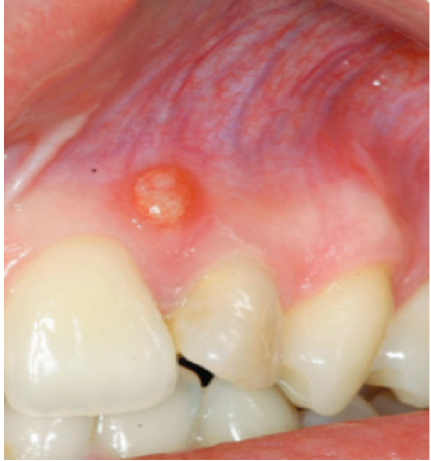
Figure 1: Starting clinical situation.